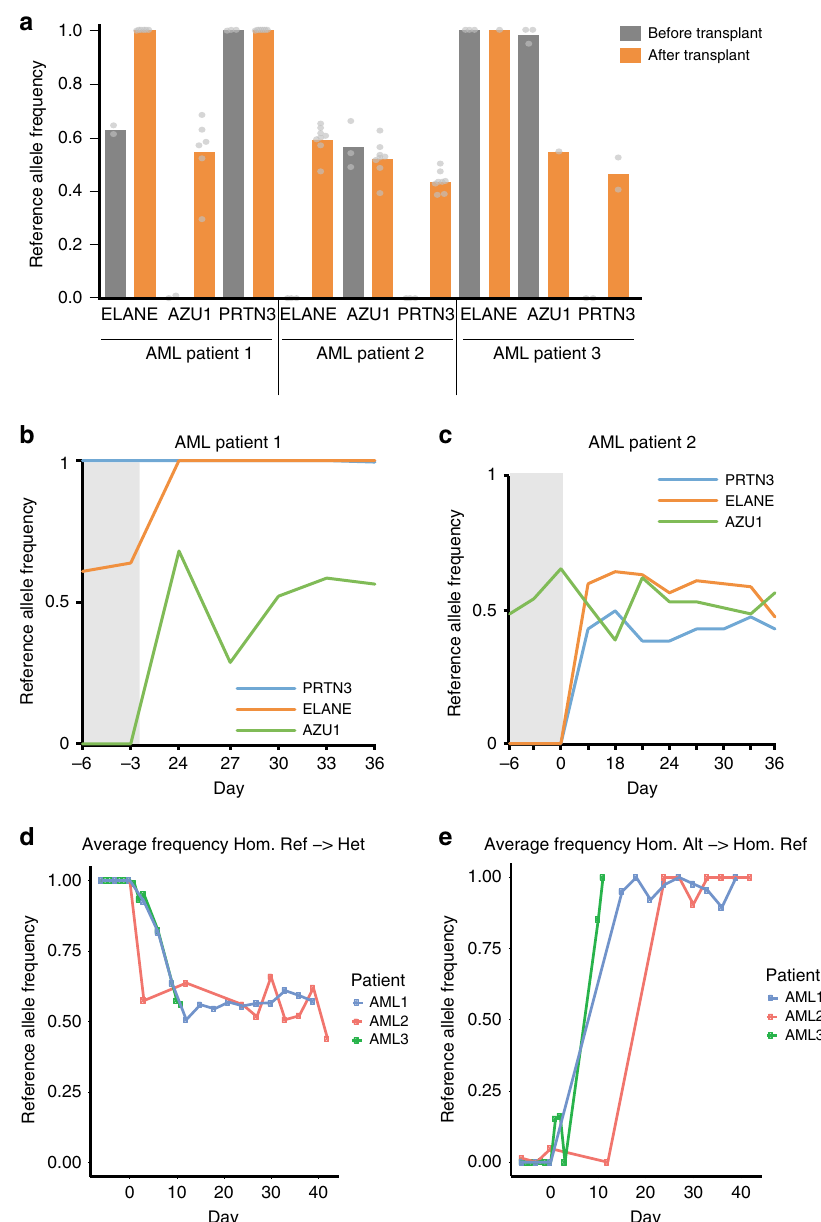
Fig. 4 Monitoring of BM allotransplant engraftment in AML patients by cf-mRNA genotyping. a . Average frequency of reference allele of the SNPs detected in ELANE, AZU1 and PRTN3 neutrophil progenitor transcripts in cf-mRNA before (gray) and after (orange) allogeneic HSC transplantation in three AML patients, showing implantation of a new genetic pro fi le after transplant. Source data are provided as a Source Data fi le. b , c . Frequency of reference allele of the SNPs detected in the same transcripts as in a for AML patients 1 and 2 over 36 days after transplant. Day of blood collection when SNPs were detected with respect to the time of transplant is indicated in the X axis. d , e Average reference allele frequency of all SNPs detected in the host cf-mRNA changing from reference homozygous to heterozygous ( d ) and from alternative homozygous to reference homozygous ( e ) after transplant. Day of blood collection is indicated in the X axis, transplant occurred at day monitoring of BM reconstitution. For example, in MM patients, remain a common practice in the therapy management of MM cf-mRNA pro fi ling integrates temporal measurement of clonal Ig patients 33 . In addition, unlike antibody detection, cf-mRNA pro fi ling has the potential for early identi fi cation of suboptimal transcripts generated by malignant plasma cells in the BM, with BM reconstitution, as shown by the lack of development of detailed BM-lineage transcriptional activity and establishment of megakaryocyte lineage in AML patient 2. While our study is a new immune pro fi le. The comprehensive picture revealed by cf- based on a limited number of patients, our data provide pro- mRNA pro fi ling provides additional relevant information com- mising initial proof of concept of using cf-mRNA pro fi ling to pared to other non-invasive tests commonly used in this malig- monitor BM activity, which could lead to improved therapeutic nancy, such as clonal antibody detection in serum of MM management of patients with BM disease, and eventually alleviate patients. Indeed, given the challenging and subjective quanti fi - the need for invasive BM biopsies. cation and characterization of these antibodies, BM biopsies